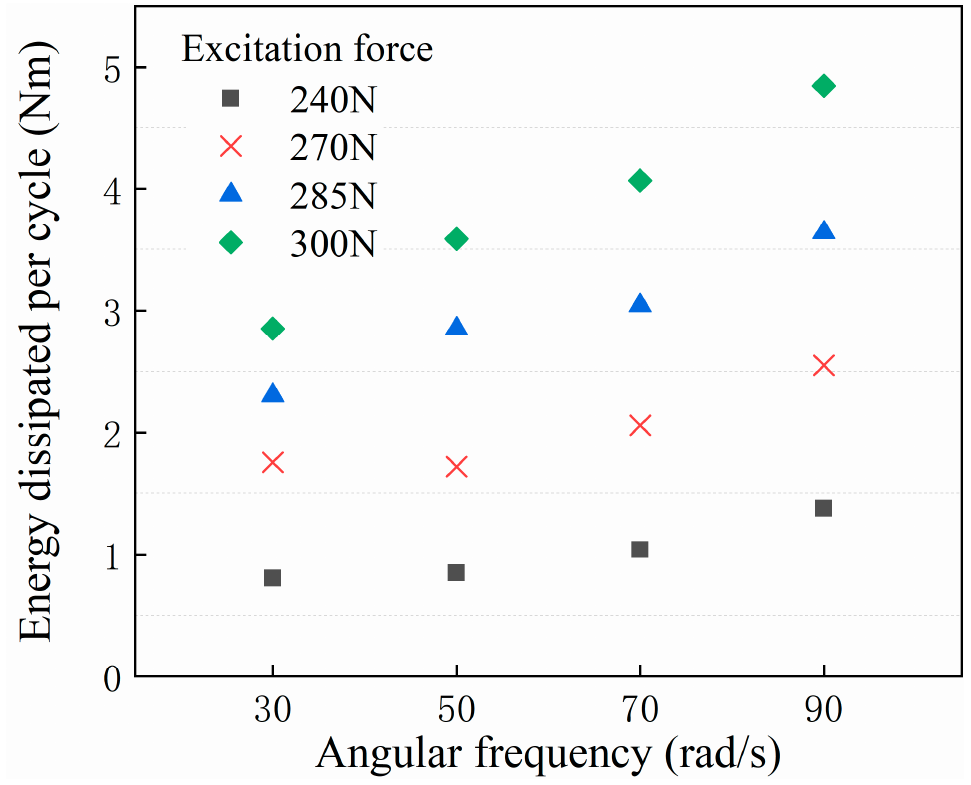
Figure 16. Energy dissipation per cycle.